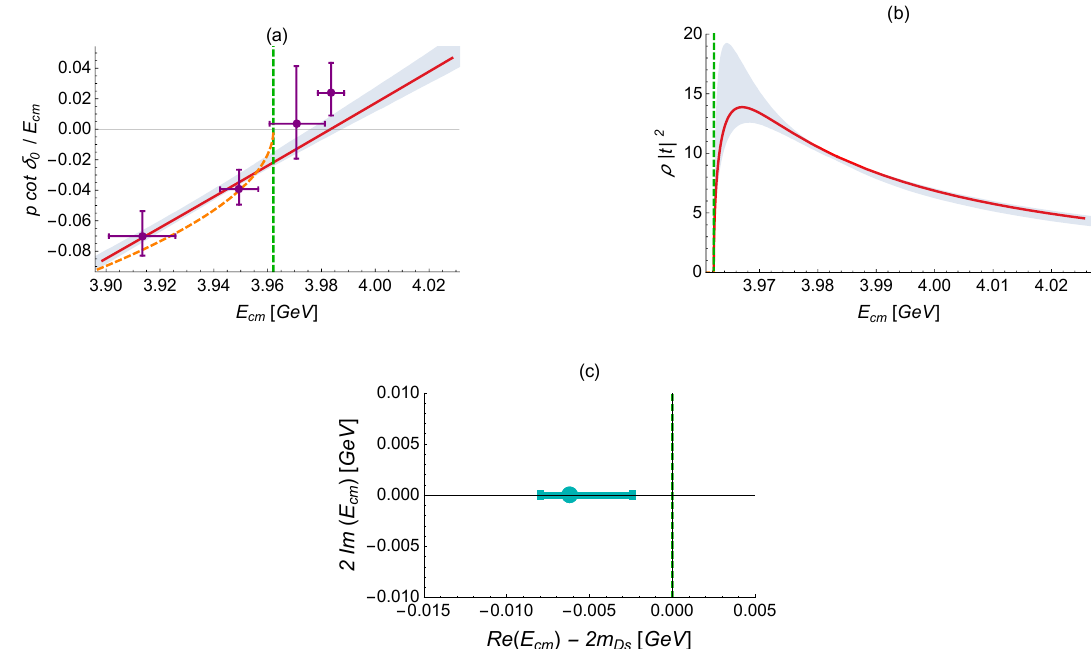
Figure 4 . D s ¯ D s scattering in partial wave l = 0 in the one-channel approximation. The green dashed line denotes the D s ¯ D s threshold in the simulation, where m D ’ 1981 MeV. (a) The violet s crosses show the quantity p cot δ/E cm , related to the scattering phase shift δ , as a function of center- of-mass energy E cm . The red line indicates the parametrization of eqs. (8.6) and (8.7). The orange line represents ip/E cm . A bound state is located at the energy where the red and orange curves intersect. (b) The quantity ρ | t | 2 that is proportional to the number of D s ¯ D s events in experiment N ∝ pσ ∝ ρ | t | 2 ( ρ = 2 p/E cm ). (c) Position of the pole of the scattering matrix on sheet I: the D s ¯ D s real component corresponds to the binding energy, presented in eq.